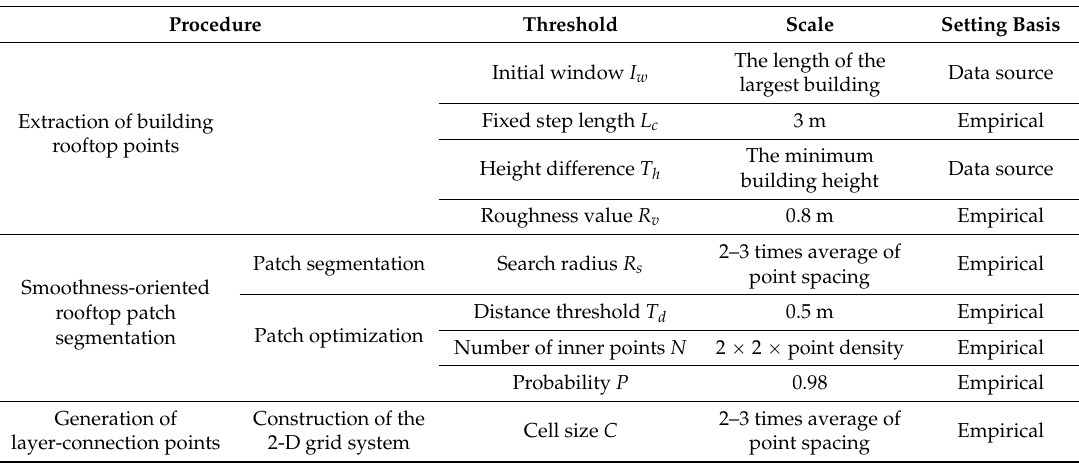
Table 1. Key parameters in the proposed